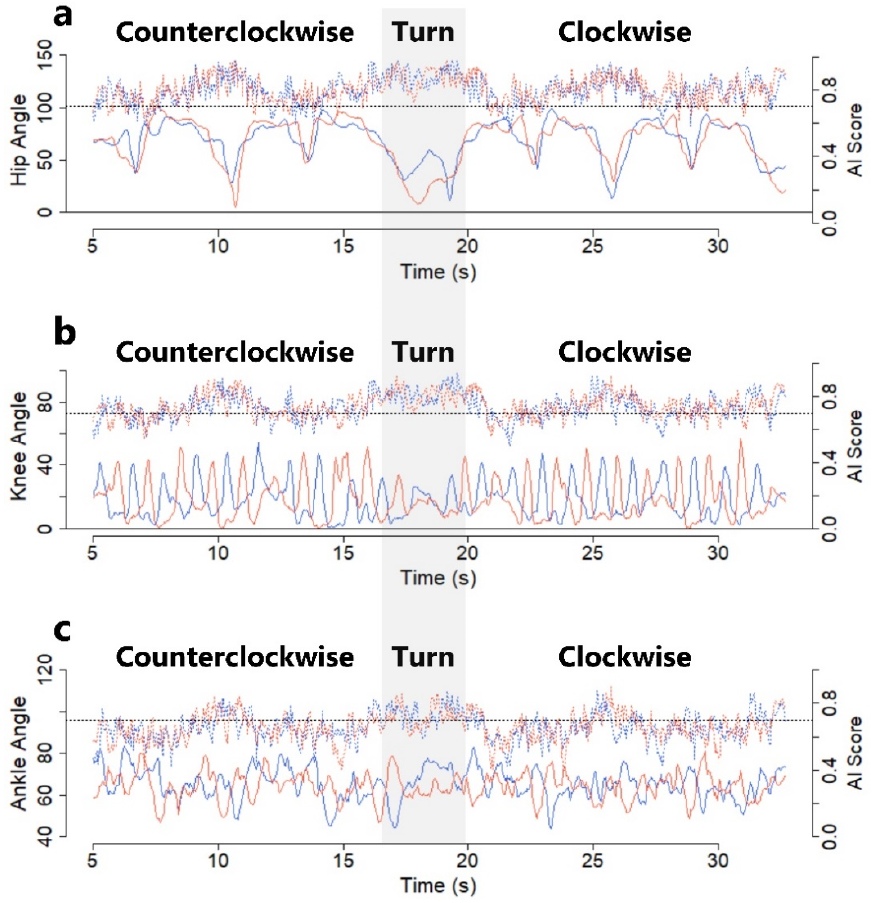
Figure 5. Three-dimensional angles (solid lines) calculated by the relative 3D coordinates estimated by the TDPT for Gait Test (TDTP-GT) application and artificial intelligence (AI) scores (dotted lines). When each AI score is 0.7 (black dotted line) or higher, the 3D angles at the right (blue) and left (red) hip joints ( a ), knee joints ( b ), and ankle joints ( c ) are considered to be relatively